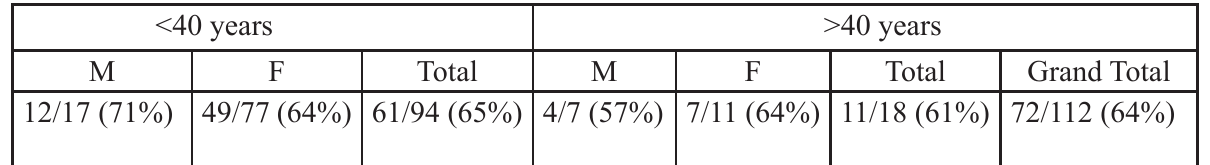
Table 2. Subject numbers (and percentages) presenting with a level of at least mild dry eye. Subjects are grouped arbitrarily into below 40 years of age and above 40 years of age. M and F indicate male and female subjects respectively. Percentages have been rounded off and are approximate.